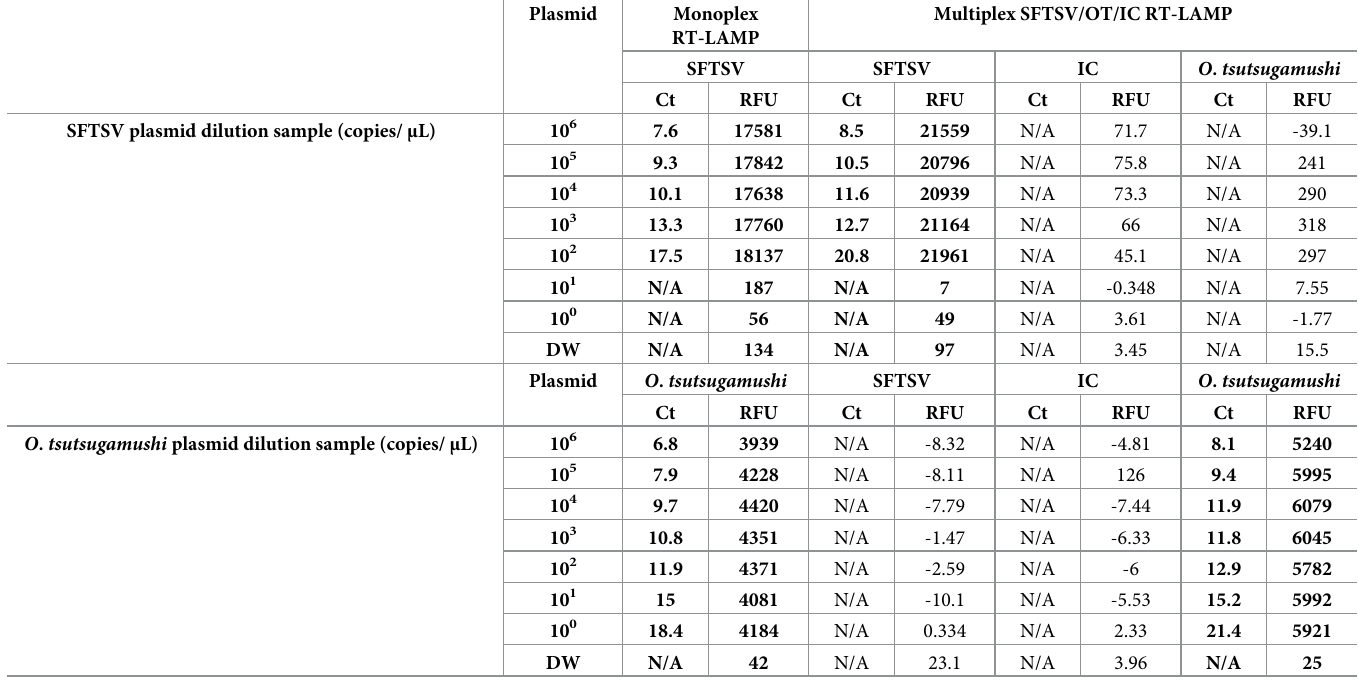
Table 2. Limit of detection test for the monoplex and multiplex SFTSV/OT/IC LAMP primer set.